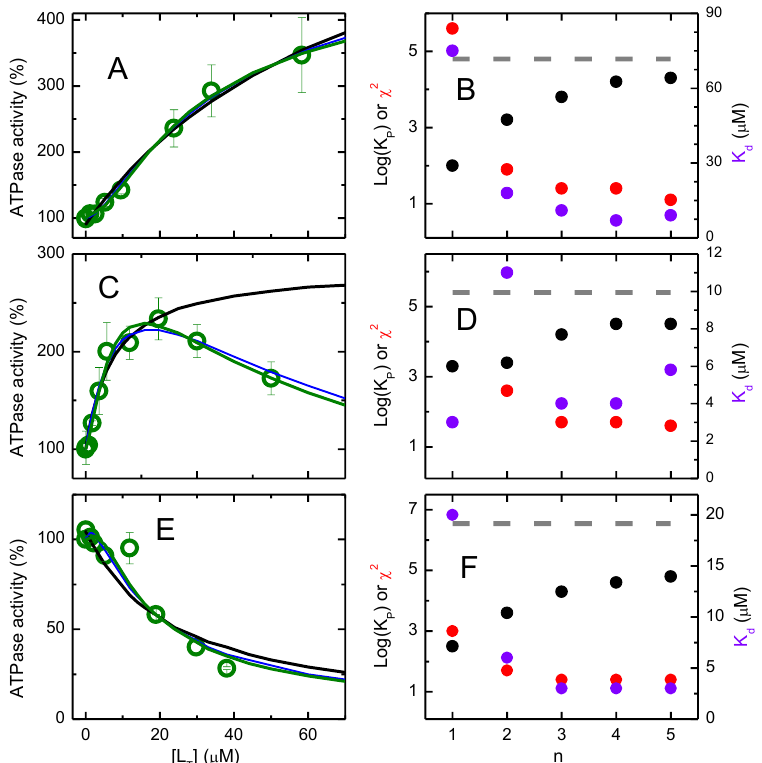
Figure 10. Effect of NBD–C4 (plot A , B ), NBD–C8 (plot C , D ), and NBD–LysoMPE (plot E , F ) on P–gp’s ATPase activity. The plots on the left show the experimental results ( ) and the best fit of Equation (9) considering different number of binding sites in P–gp’s binding pocket: n = 1 ( – ), n = 2 ( – ), and n = 5 ( – ). The plots on the right show the effect of the number of binding sites on the quality of the best fit ( χ 2 , • ), on the value of the microscopic dissociation constant ( K d , • ), and on the partition coefficient calculated from β 1 ( • ). The partition coefficient between the aqueous phase and P–gp obtained from the partition experiments is also shown (- -